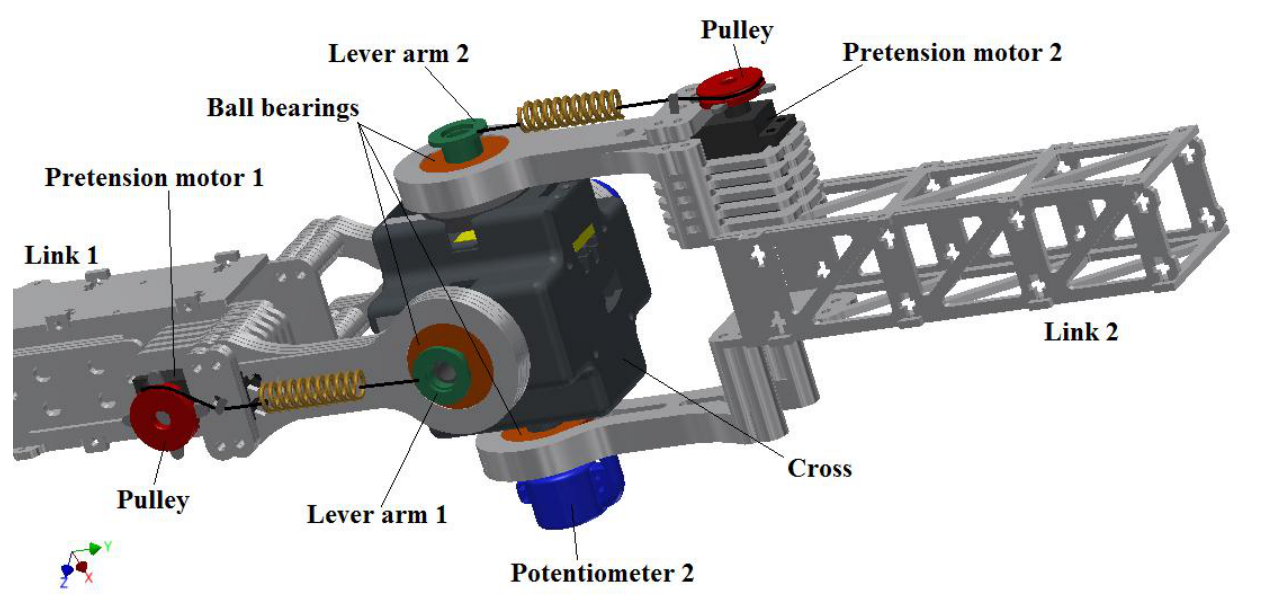
Figure 3. CADdrawing of the presented two-degree of freedom